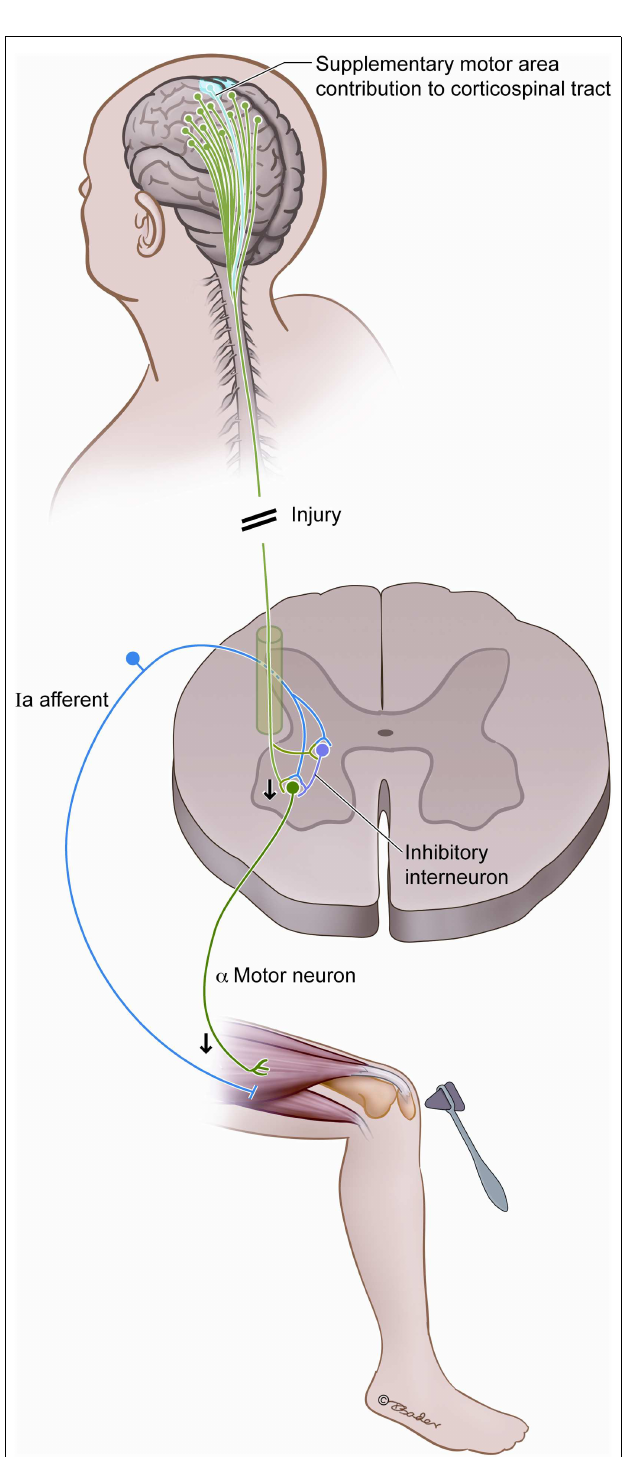
FIGURE 3 | Postulated interplay between the SMA and the spinal reflex arc. We hypothesize that compromise of the SMA fibers diminishes reflex responsiveness by decreasing the excitability of alpha motor neurons, and this is a source of acute hyporeflexia after upper motor neuron injury such as spinal shock and SMA